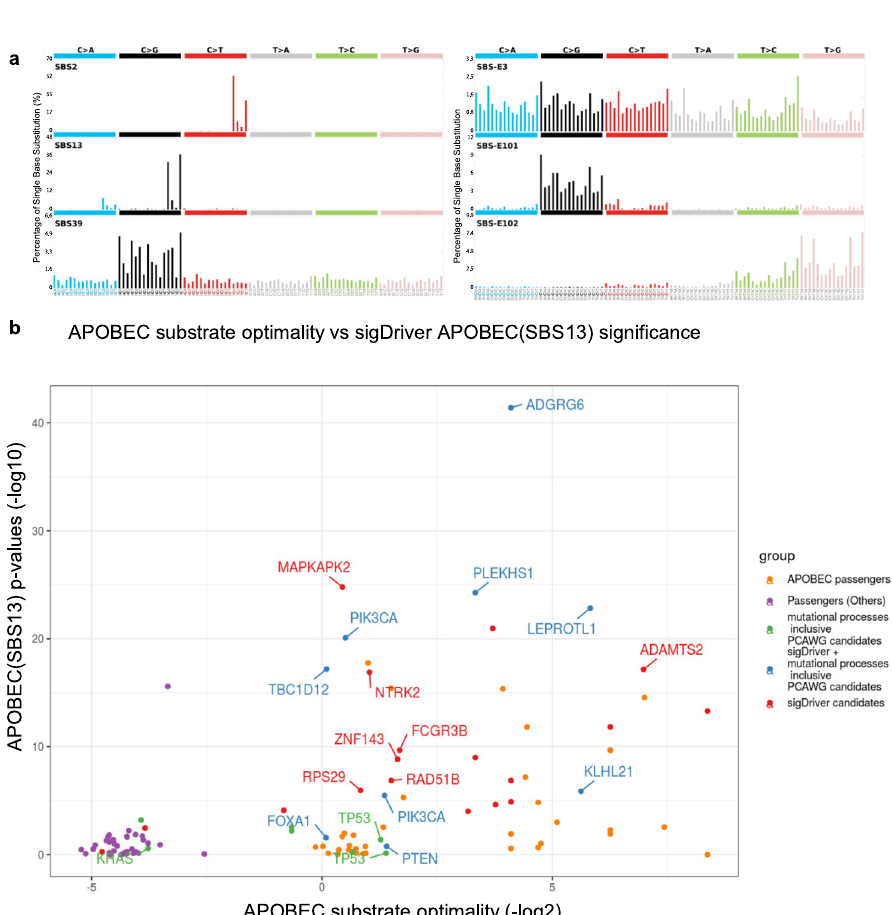
Fig. 3 Selected mutation spectra of COSMIC SBS V3 and NxSxN signatures and analysis of APOBEC substrate optimality in relation to sigDriver APOBEC(SBS13) signi fi cance. a The mutation spectrum of signatures from COSMIC SBS V3 signatures and NxSxN-extended signatures. The left panel is showing the mutation spectrum of the APOBEC signatures (SBS2/SBS13) and signature SBS39 under the COSMIC SBS V3 signature de fi nition. The right panel is showing the mutation spectrum of the defective homologous recombination signature SBS-E3 and signatures SBS-E101, SBS-E102 in the NxSxN- extended signature de fi nition. b APOBEC substrate optimality analysis on recurrent hotpots tested by sigDriver. Hotspots were extracted from APOBEC positive tumors (more than 5% activity) for APOBEC substrate optimality analysis by ApoHP 30 . Potential drivers reported by PCAWG, sigDriver and the overlap of the two were annotated per hotspot. Spearman ’ s correlation between the APOBEC substrate optimality and the sigDriver signi fi cance was used to assess the relationship between the two. Source data are provided as a Source Data fi